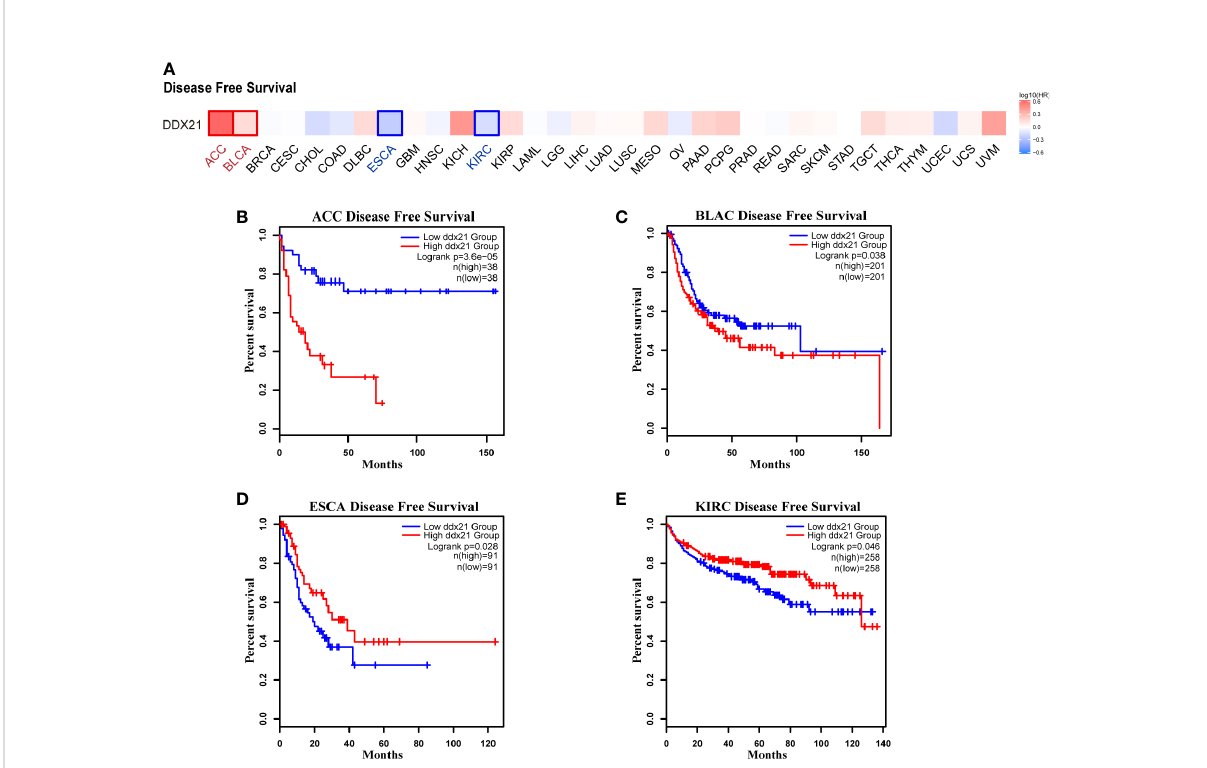
FIGURE 4 Correlation between DDX21 expression and disease-free survival (DFS) in patients with different TCGA tumor types. GEPIA2 was used to build a survival map (A) and conduct DFS (B – E) analyses. The survival map and Kaplan – Meier plots with signi fi cant results are displayed. The 95% con fi dence intervals of DFS are indicated by red and blue dotted lines for high and low DDX21 expression groups,